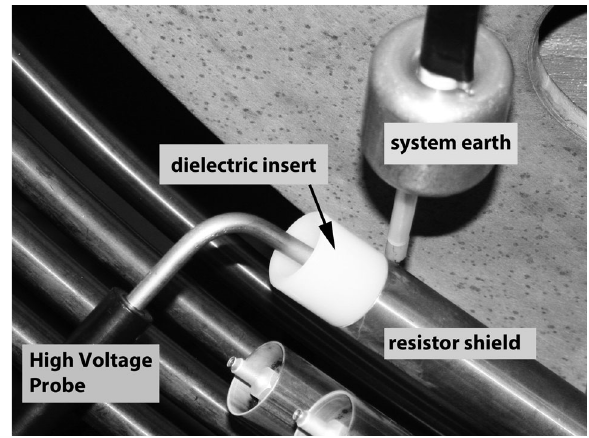
FIG. 4. In-machine high-voltage individual resistor testing procedure. The dielectric insert is made of nylon 6. The conductive leads between the neighbor resistors are removed.